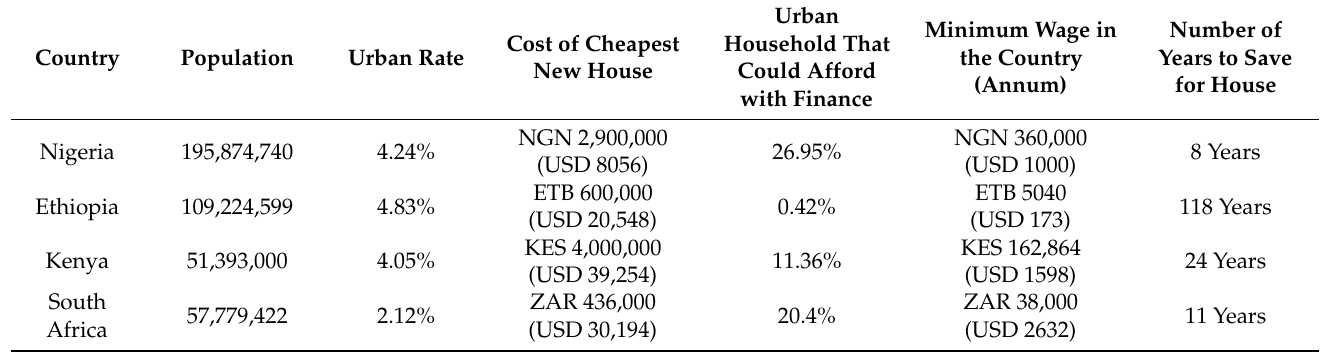
Table 1. Minimum wage and housing affordability